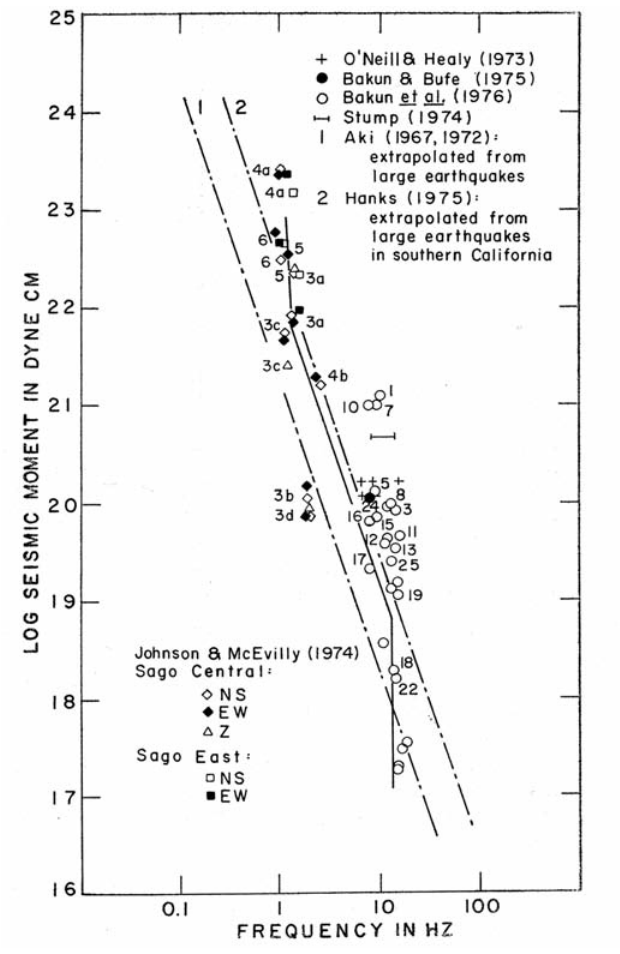
Figure 1. Growth of the seismic source spectrum with magnitude for earthquakes in the San Andreas rift zone near Stone Canyon, central California. The locus of corner frequencies appears to consist of three distinct segments between magnitudes 1 (M 1) and 5 (M 5). Reproduced from Chouet et al. [1978].